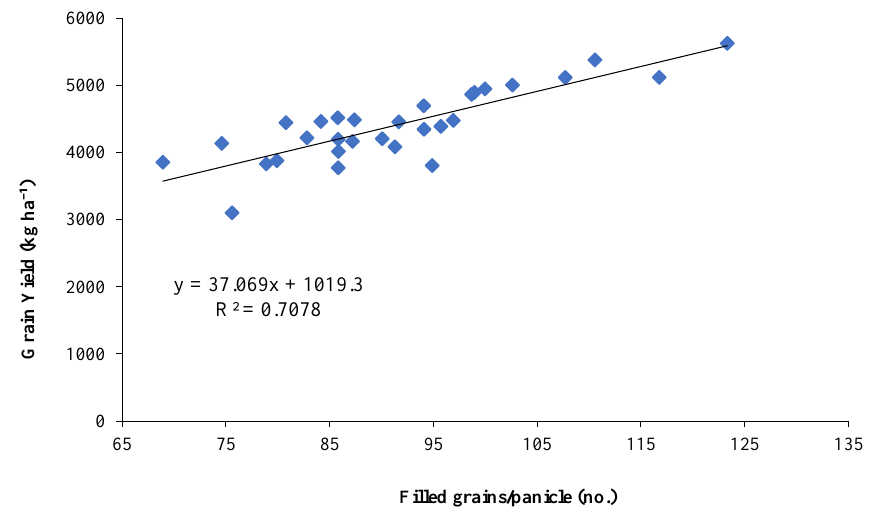
Filled grains/panicle (no.) Figure 3. Linear regression between yield (kg ha⁻ 1 ) and filled grain/panicle (no.) of “Pratikhya” Kha- Figure 3. Linear regression between yield (kg ha − 1 ) and filled grain/panicle (no.) of “Pratikhya” rif rice variety. Kharif rice